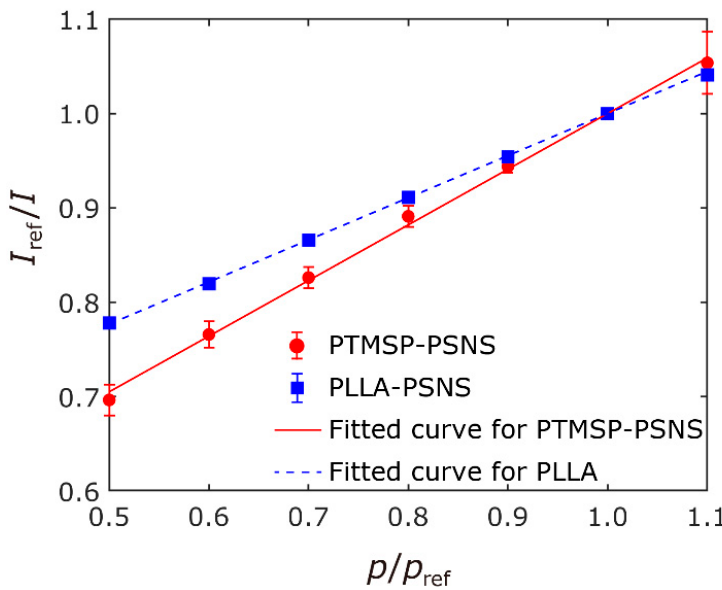
Figure 3. Stern–Volmer plots for PTMSP-PSNS and PLLA-PSNS samples.